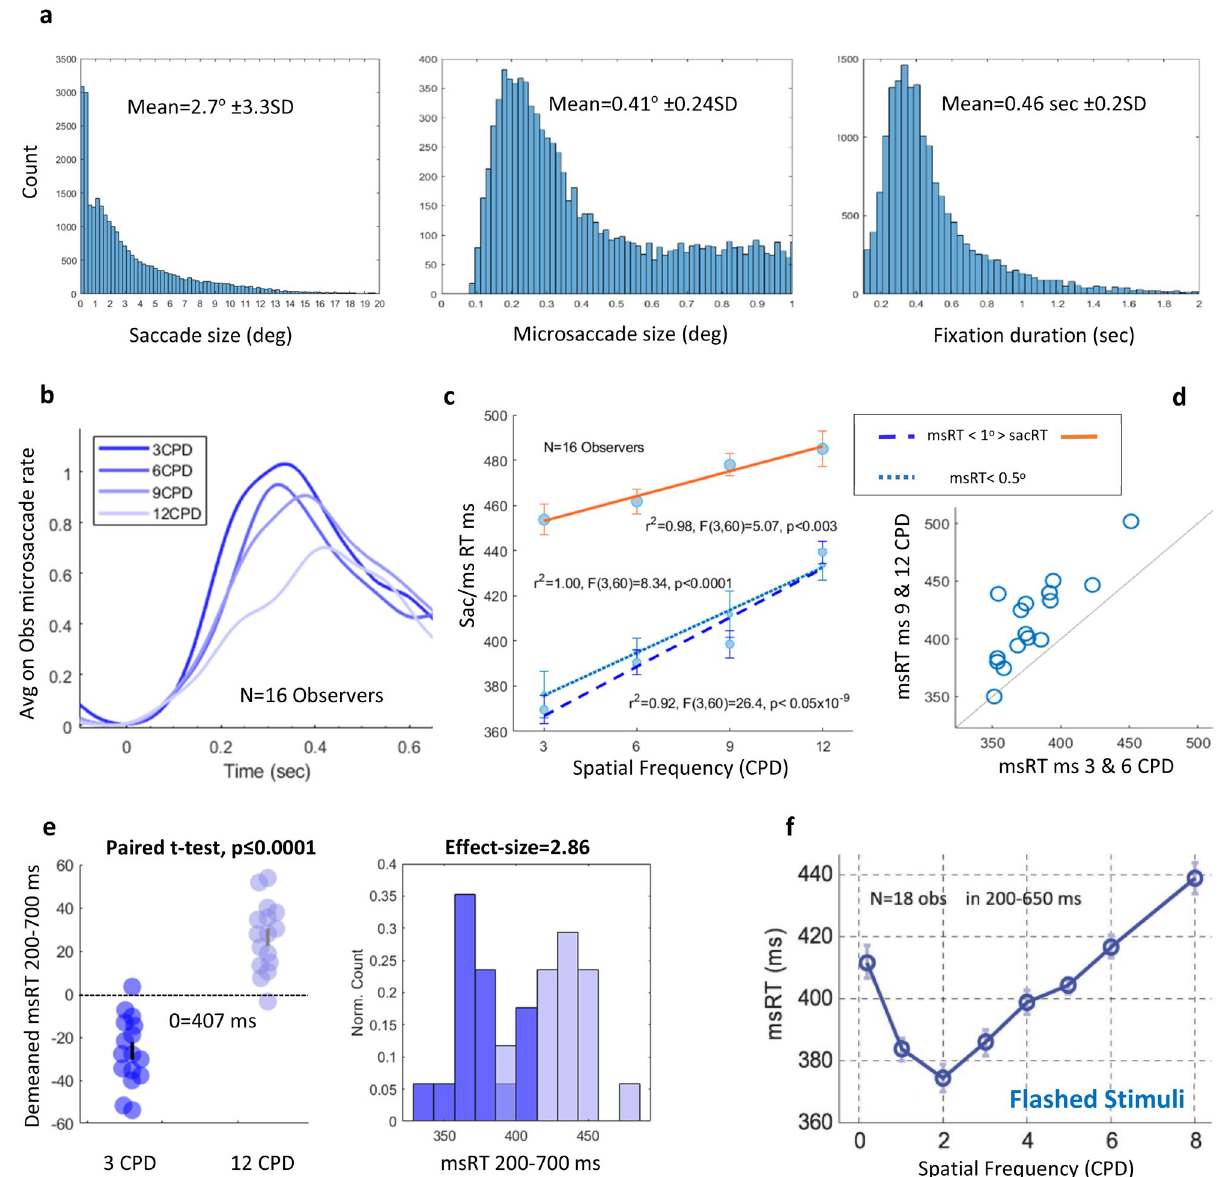
Figure 4. The results for experiment 2: The effect of spatial frequency. ( a ) The frequency histograms under all conditions and for all observers combined. (Left) A saccade size histogram including microsaccades. (Middle) Microsaccades up to 1° histogram. (Right) Fixation duration up to a 2 s histogram. ( b ) The fixation-related MS rate per second averaged across observers (n = 16). ( c ) The fixation-related msRT and sacRT (calculated over MS-free fixations) as a function of SF averaged across observers (n = 16), with 1SE error bars computed on the demeaned (see the “Methods” section), all showing a similar positive linear trend. msRT (< 1°, dashed blue line), r 2 = 0.92, F(3,60) = 26.4, p < 0.05 × 10 –9 , One-way Anova. msRT (< 0.5°, dotted light blue line), r 2 = 1, F(3,60) = 8.34, p < 0.0001, One-way Anova. sacRT (> 1°, orange line ), r 2 = 0.98, F(3,60) = 5.07, p < 0.003, One-way Anova. ( d ) A diagonal scatter plot of the individual observer’s msRT results for a low SF on the X-axes and high SF on the Y-axes, showing that most observers are above the diagonal line indicating longer msRTs for the high SF. ( e ) A comparison between the two extremes; 3 and 12 CPD show longer msRTs for the higher SF, p ≤ 0.0001, paired t-test (left panel). Histogram comparisons of 3 and 12 CPD showing a huge effect size, ES = 2.86, Cohen’s d (right panel). ( f ) The results for msRT as a function of spatial frequency taken from a previous study of flashed stimuli for comparison 28 , with a notable similarity in the relevant SF